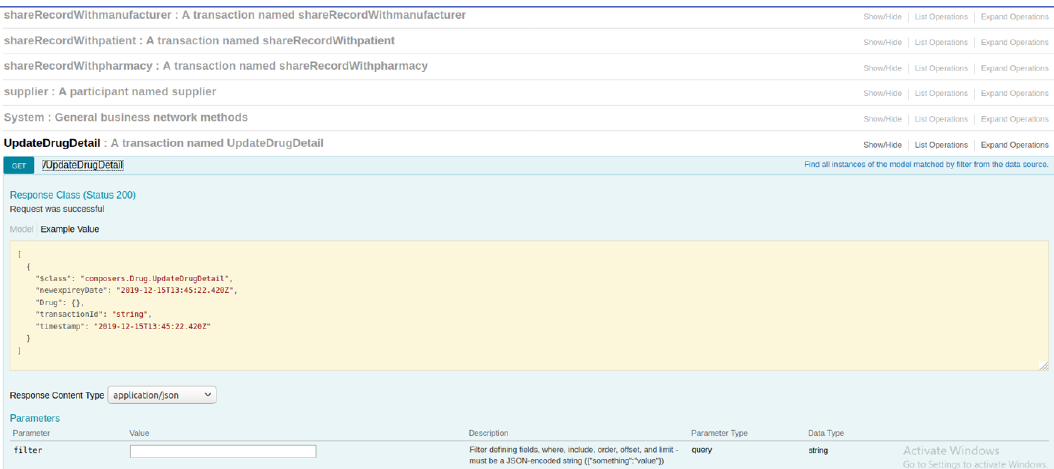
Figure 14. Add drugs web form of client web application.